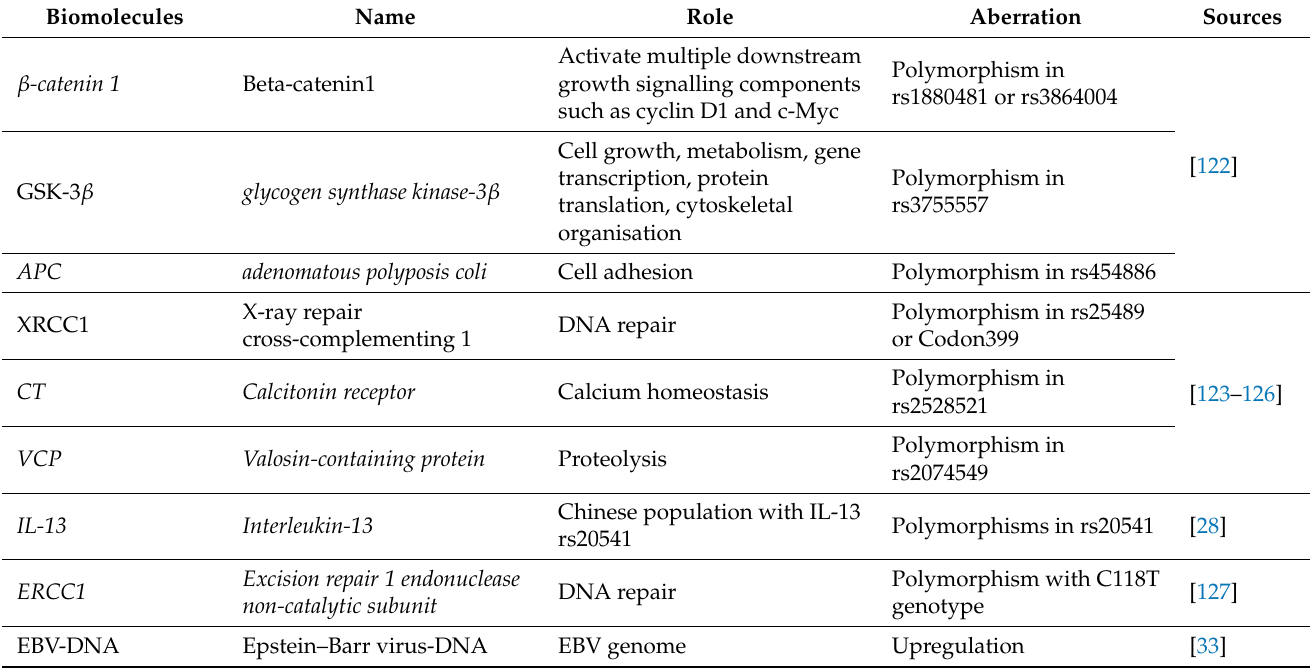
Table 2. Potential prognosis and predictive biomarkers for NPC therapeutic resistance or metastasis and recurrence after